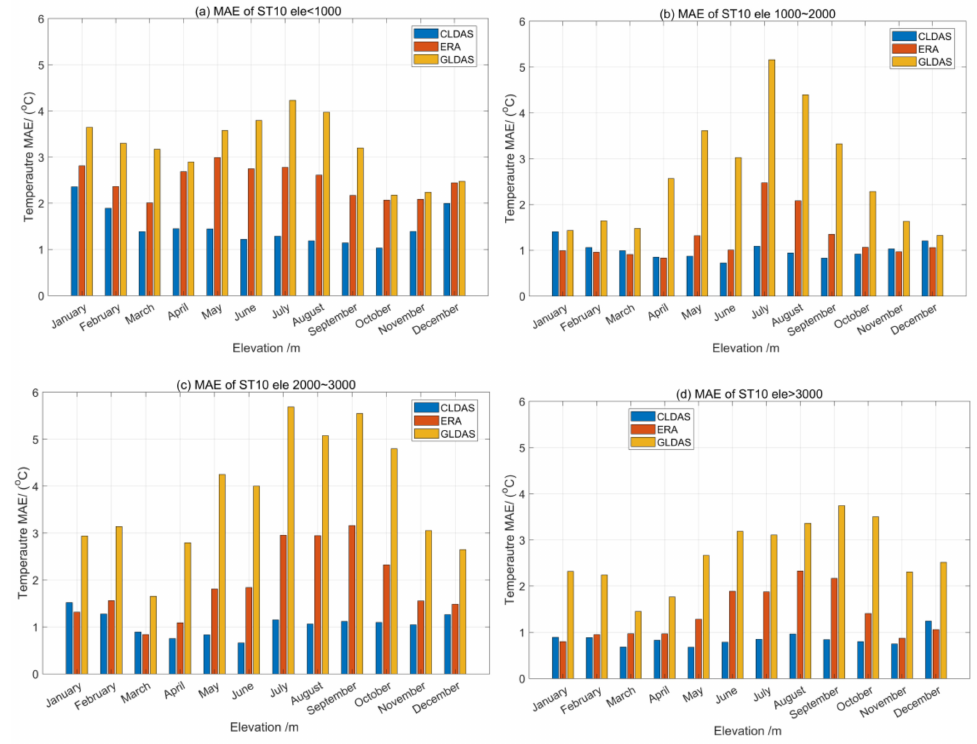
Figure 8. Monthly MAEs of ST10 in different elevations of 2017. Elevation <1000 ( a ), 1000–2000 ( b ), 2000–3000 ( c ), >3000 ( d